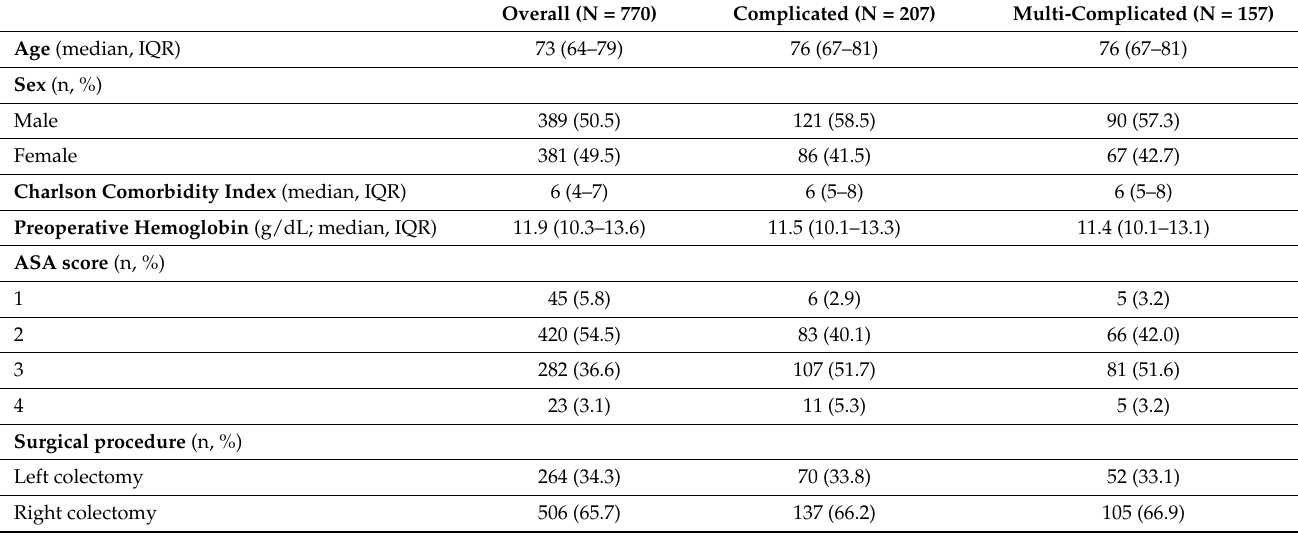
Table 1. Characteristics of the study